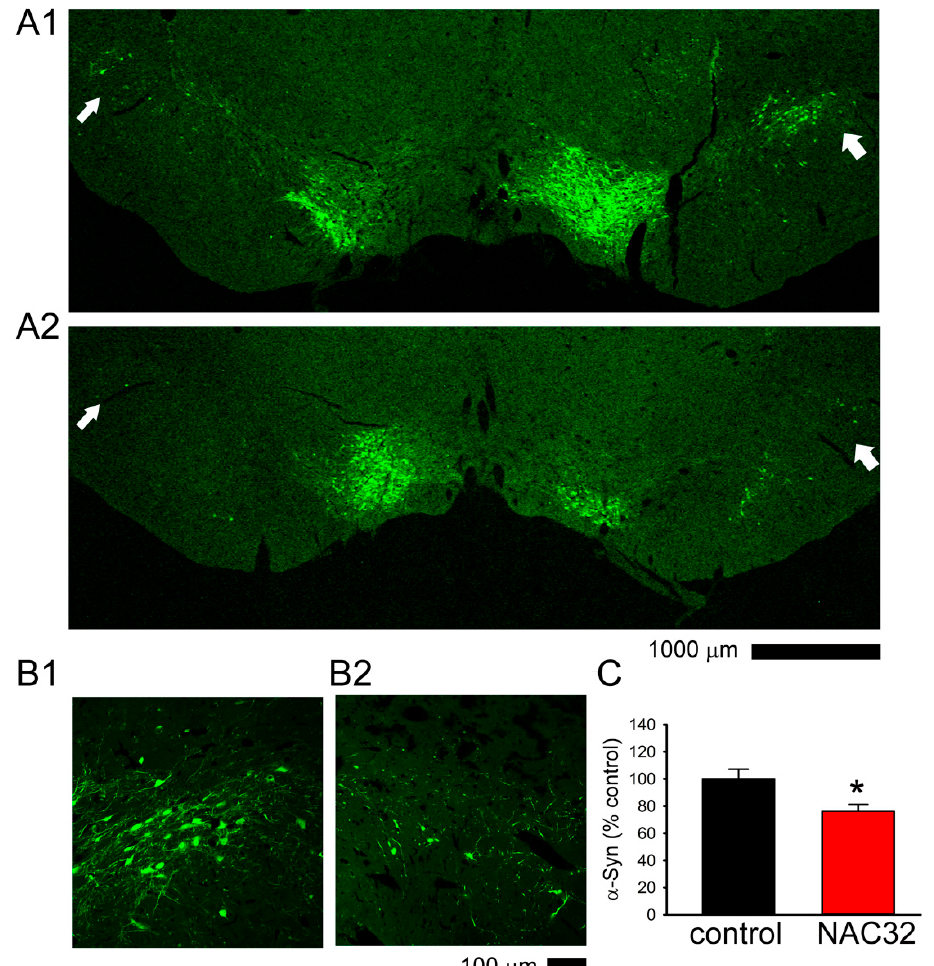
Figure 8. AAV-NAC32 reduced the expression of V5- α Syn in nigra. Representative photomicrographs of V5- α Syn-ir in the SNcd of animals receiving AAV-mCherry ( A1 , low magnification; B1 , high magnification) or AAV-NAC32 ( A2 , low magnification; B2 , high magnification). The expression of V5- α Syn in the SNcd (arrows, A1 vs. A2 ; B1 vs. B2 ) was reduced bilaterally after AAV-NAC32 injection. ( C ) V5- α Syn-ir was averaged in the SNcd (as seen in the dotted area in Figure 7B1). AAV-NAC32 significantly reduced V5- α Syn-ir in SNcd (* p = 0.018, t -test).